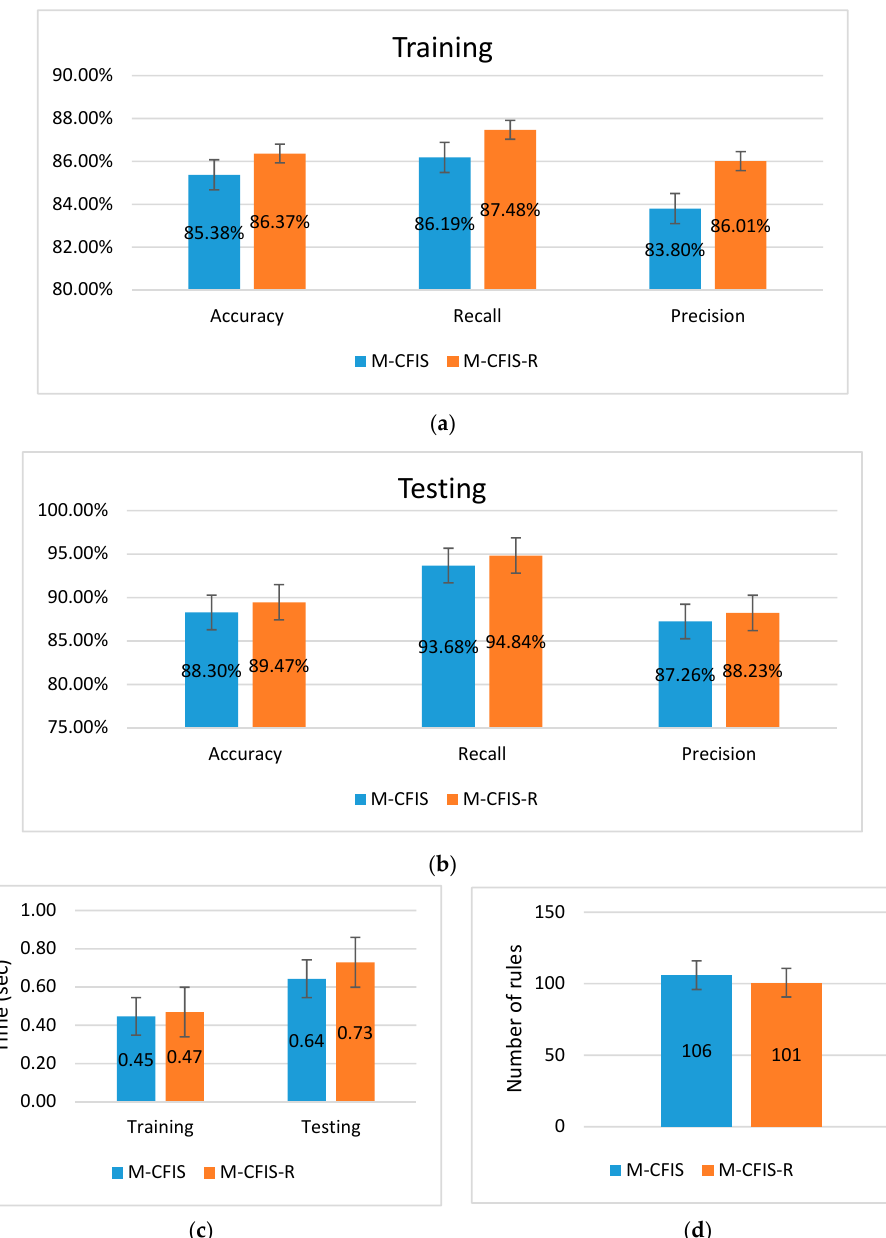
Figure 5. Performance on the Diabetes dataset: ( a ) Accuracy, Recall, Precision on training set; ( b ) Accuracy, Recall, Precision on testing set; ( c ) Time consumed; ( d ) Number of rules.